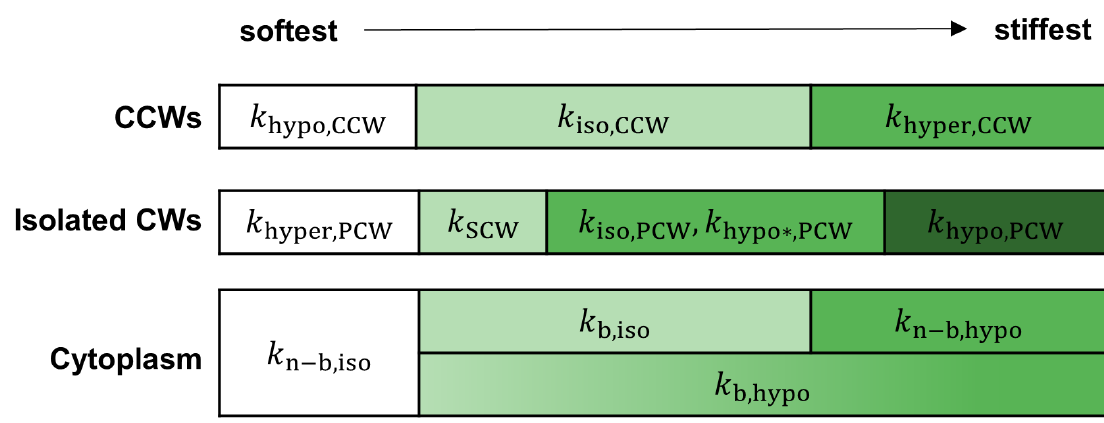
Figure A5. Panel showing stiffness in hypertonic, isotonic, and hypotonic solutions in 4 stages of transdifferentiation: ( A ) stage 0; ( B ) stage 1; ( C ) stage 2; ( D ) stage 3. Stars indicate significant differences in distribution according to a Kolmogorov-Smirnov test. * p < 0.1, ** p < 0.05, *** p < 0.01.